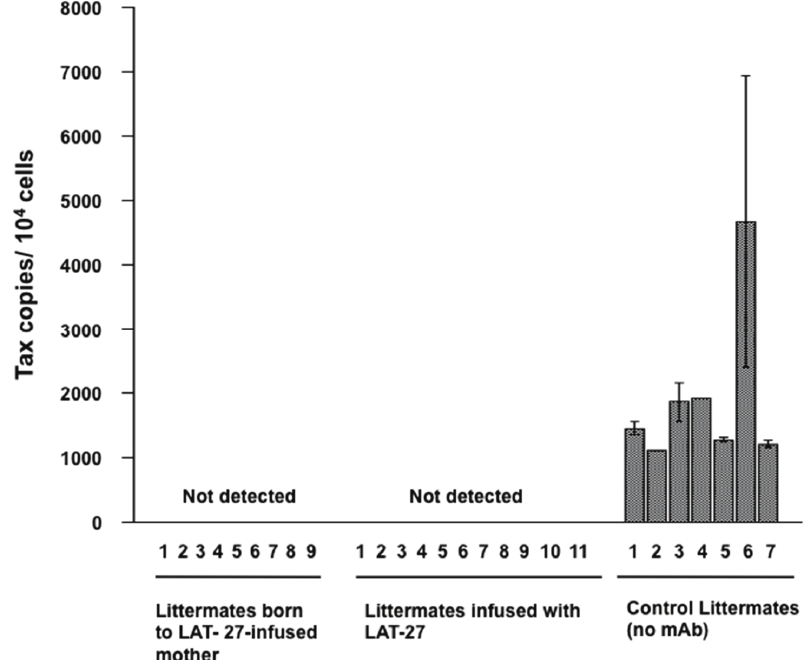
Figure 2. Protection of newborns from HTLV-I infection by mother-to-child-transferred LAT-27. Nine littermates from LAT-27 passively immunized mother rat ( left ), 11 littermates directly injected with LAT-27 ( center ) before infection, and seven naïve littermates ( right ) were i.p. injected with MMC-treated ILT-M1 cells. After three weeks, rats were tested for HTLV-I infection.